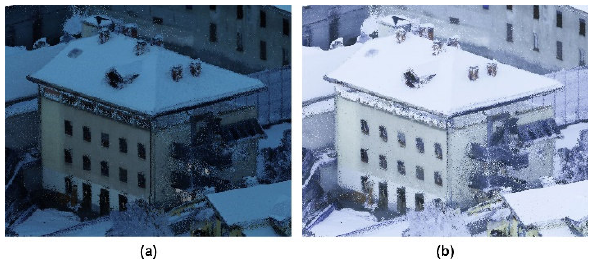
Figure 2. Radiometric information enhancement. Point cloud processed with acquired images (a) and after image correction (b).